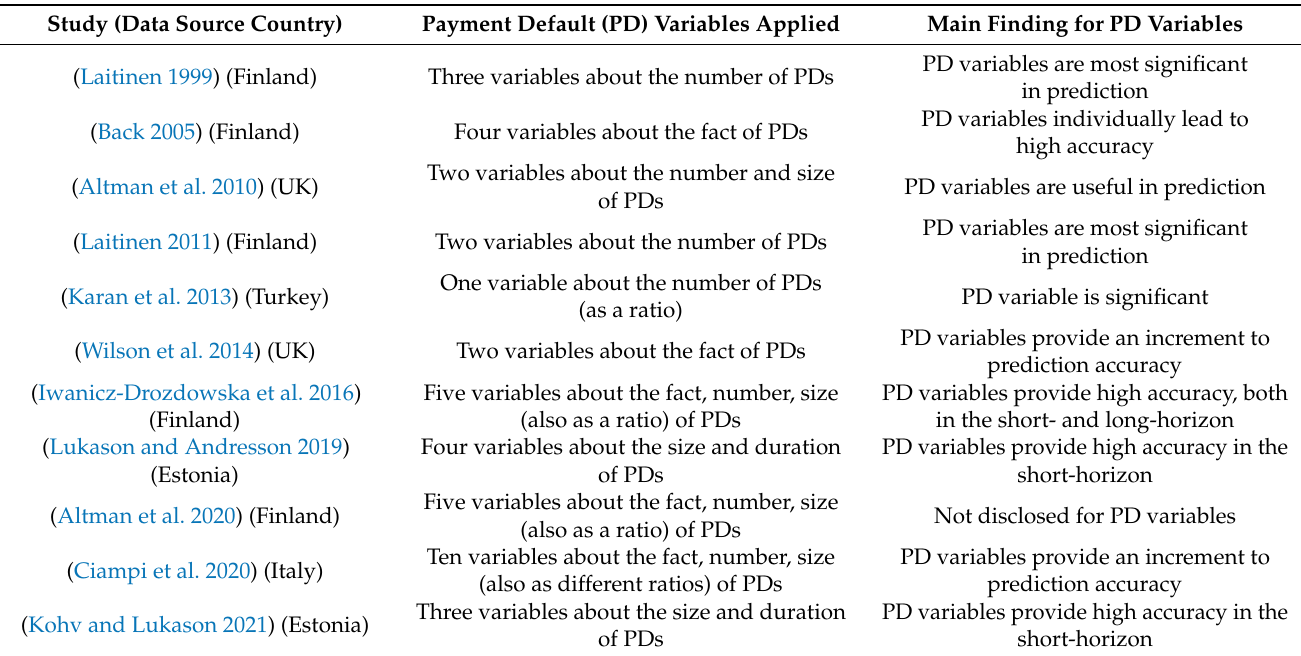
Table 1. Studies incorporating payment default variables for failure